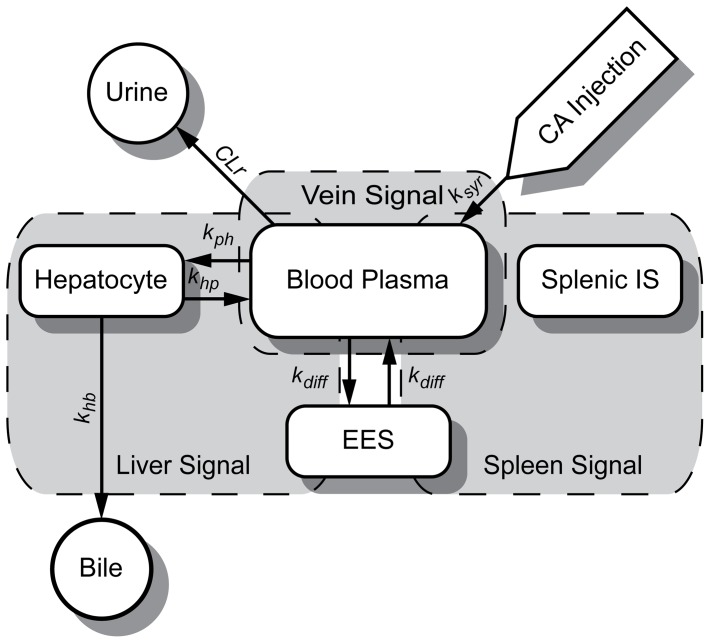
Diagram of the proposed model.Schematic diagram of the proposed model (M0). The rounded edge rectangles represent the different compartments in the model connected with arrows showing the direction of the CA fluxes, with the associated rate parameters. The Hepatocyte compartment represents all intracellular water within the liver, and the Splenic IS represents the structures within the spleen that are inaccessible to EOB. The white pointed rectangle (CA Injection) represents the administration of EOB to the system. The white circles are the sinks of the system, meaning that once the CA has reached the ‘Urine’ and ‘Bile’ compartments it cannot be transferred back into the system. The signal model is represented by the dashed grey boxes (liver, vein and spleen respectively), showing the congregation of compartments for the conversion from CA concentration to relative change in relaxivity that is comparable to the data from the ROIs. The fractions of the compartments used in each MRI signal simulation can be found in Table 2. Both the plasma and EES compartments are shared between the liver and spleen MRI signals.